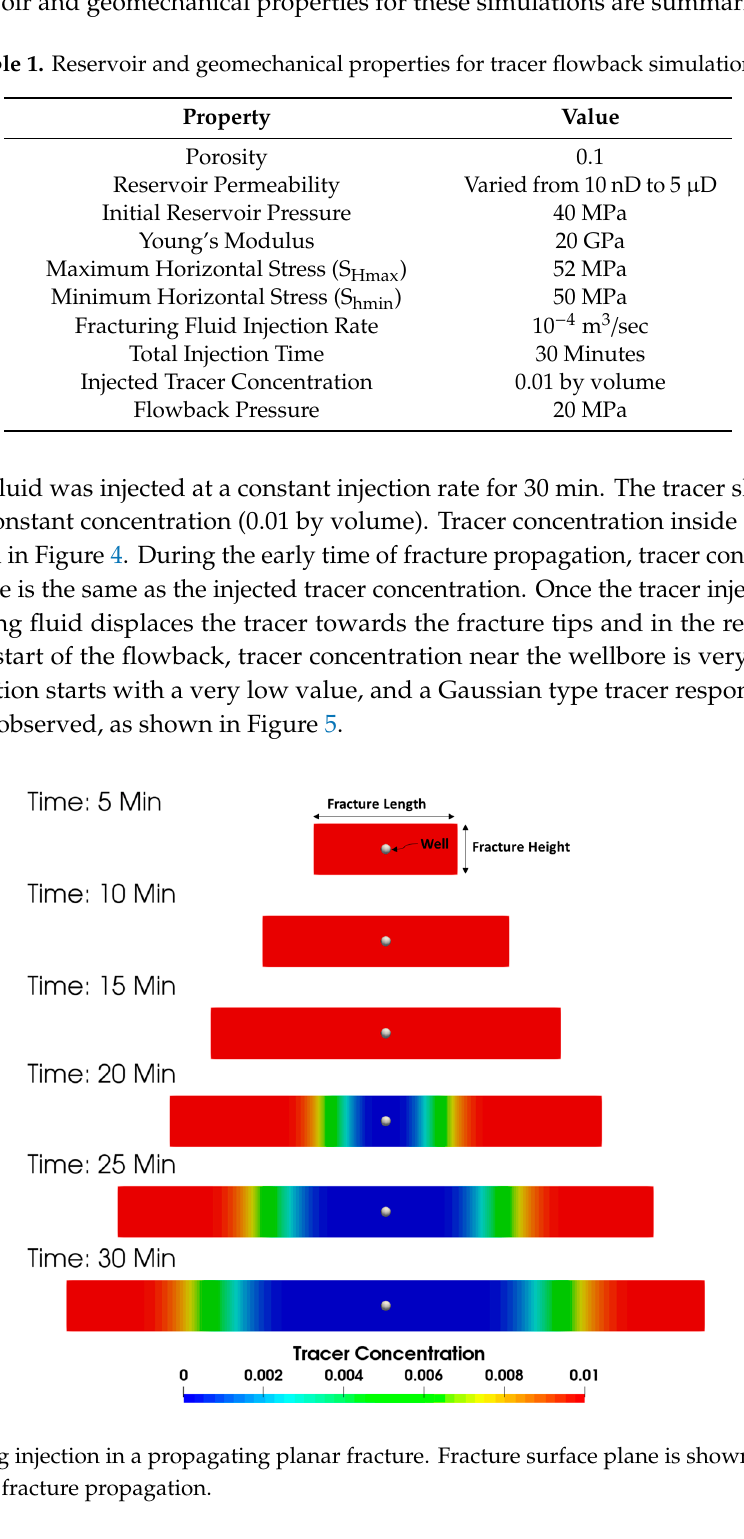
Figure 5. Tracer response curve from a slug injection tracer flowback. 3.1. Impact of Fracture Length on Tracer Response Curves Preliminary tracer tests were simulated to obtain tracer response curves by varying reservoir permeability from 10 nD to 5 µD. An increase in the reservoir permeability leads to a decrease in the created hydraulic fracture length due to higher leak-off rates (all other parameters are kept constant). The objective of these simulations was to analyze the difference in the tracer response curves to get some qualitative information about fracture length. An equal volume of tracer was injected in all cases, and the flowback was performed at the same constant bottom-hole pressure in each case. In these preliminary simulations, fracture closure during flowback was not considered. For this analysis, the tracer concentration in the flowback fluid was normalized against injected tracer concentration, as explained in Equation (16). 𝑁𝑜𝑟𝑚𝑎𝑙𝑖𝑧𝑒𝑑 𝑇𝑟𝑎𝑐𝑒𝑟 𝐶𝑜𝑛𝑐𝑒𝑛𝑡𝑟𝑎𝑡𝑖𝑜𝑛 (𝐶 (cid:3005) ) = 𝑇𝑟𝑎𝑐𝑒𝑟 𝐶𝑜𝑛𝑐𝑒𝑛𝑡𝑟𝑎𝑡𝑖𝑜𝑛 𝑖𝑛 𝐹𝑙𝑜𝑤𝑏𝑎𝑐𝑘 𝐼𝑛𝑗𝑒𝑐𝑡𝑒𝑑 𝑇𝑟𝑎𝑐𝑒𝑟 𝐶𝑜𝑛𝑐𝑒𝑛𝑡𝑟𝑎𝑡𝑖𝑜𝑛 (16) Normalized tracer concentration (𝐶 (cid:3005) ) vs. time is plotted on a semi-log scale for all reservoir permeability (𝐾 (cid:3040) ) cases (Figure 6). It was observed that an increase in the reservoir permeability